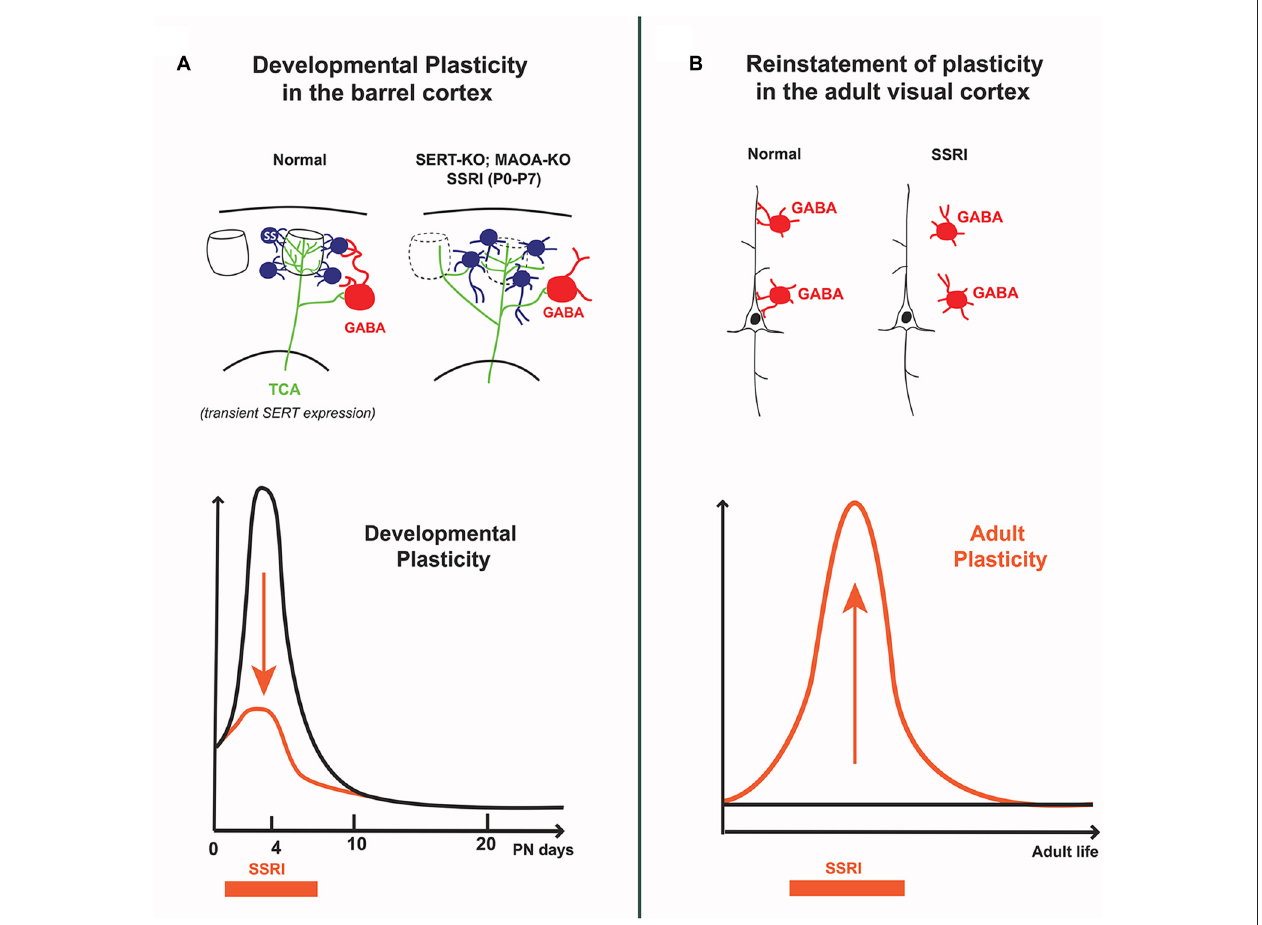
FIGURE 2 | Differential effects of 5-HT on cortical circuits assembly and plasticity in early postnatal vs. adult life. (A) In the developing barrel cortex, transient excess of 5-HT (i.e., SERT-KO, MAOA-KO and 5-HT selective reuptake inhibitors (SSRI) exposure from P0 to P7) alters the “barrel map” circuit organization; thalamocortical axons extend across different barrel domains and spiny stellate neurons in layer 4 do not orient dendrites toward barrel centers, furthermore their axons abnormally extend into the lower cortical layers. Decreased feed-forward inhibition is also observed, indicating that both excitatory and inhibitory cortical circuits are modified by early exposure to 5-HT. (B) In the adult visual cortex, SSRI exposure increases 5-HT levels and reinstates ocular dominance (OD) plasticity which is normally absent at this stage; this involves a reduction in the inhibitory control of cortical pyramidal neurons by local GABA interneurons. The curves schematize the different effects of SSRIs at different life periods: during early postnatal life SSRIs dampen developmental plasticity, whereas in adults SSRIs increase cortical plasticity.